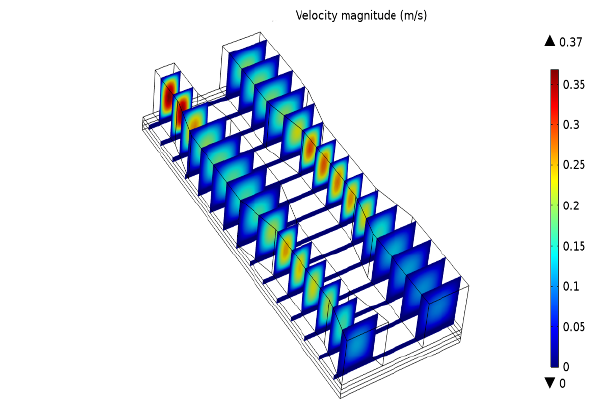
Figure 4. Velocity distribution in conventional channel and novel channel.